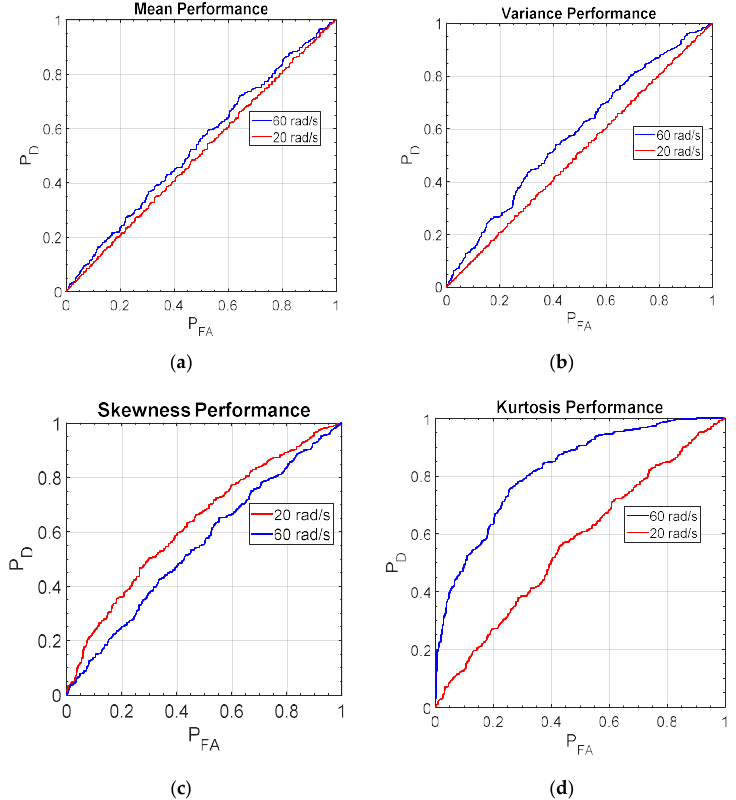
Figure 10. Open switch fault (duration 100 µs) detection performance with SNR = 20 dB: ( a ) With mean value, ( b ) With variance, ( c ) With Skewness, ( d ) With Kurtosis.